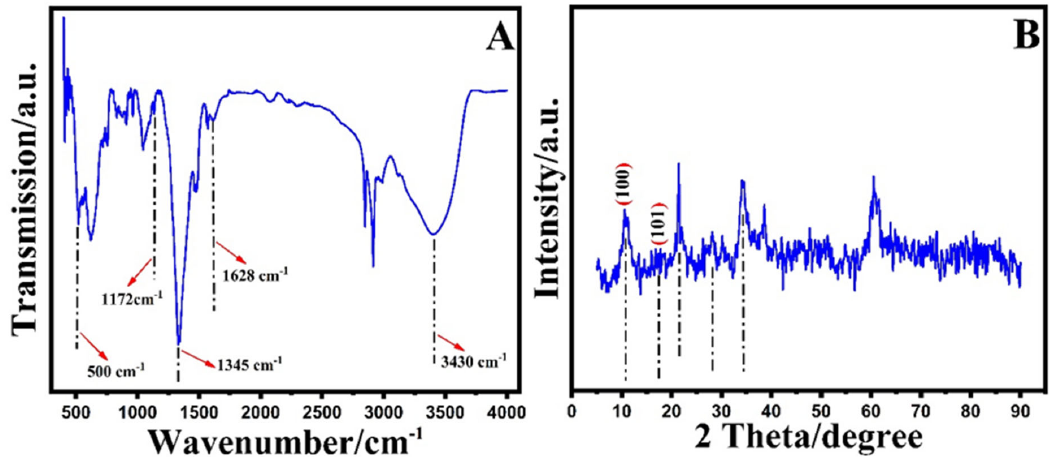
Figure 2. ( A ) FT-IR spectrum and ( B ) XRD pattern of MIP-Co/Ni@MOF. Figure 2. ( A ) FT ‐ IR spectrum and ( B ) XRD pattern of MIP ‐ Co/Ni@MOF.